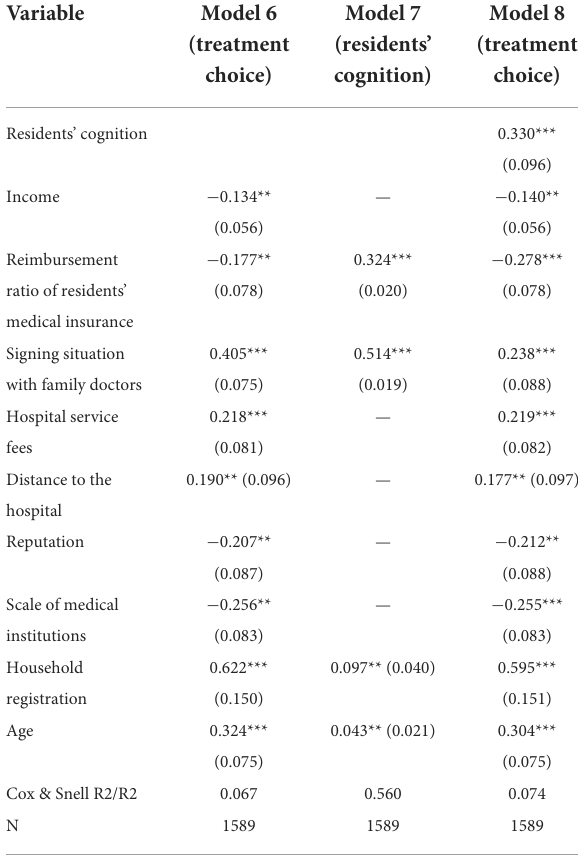
TABLE 5 Testing results of mediating effect of residents’ cognition